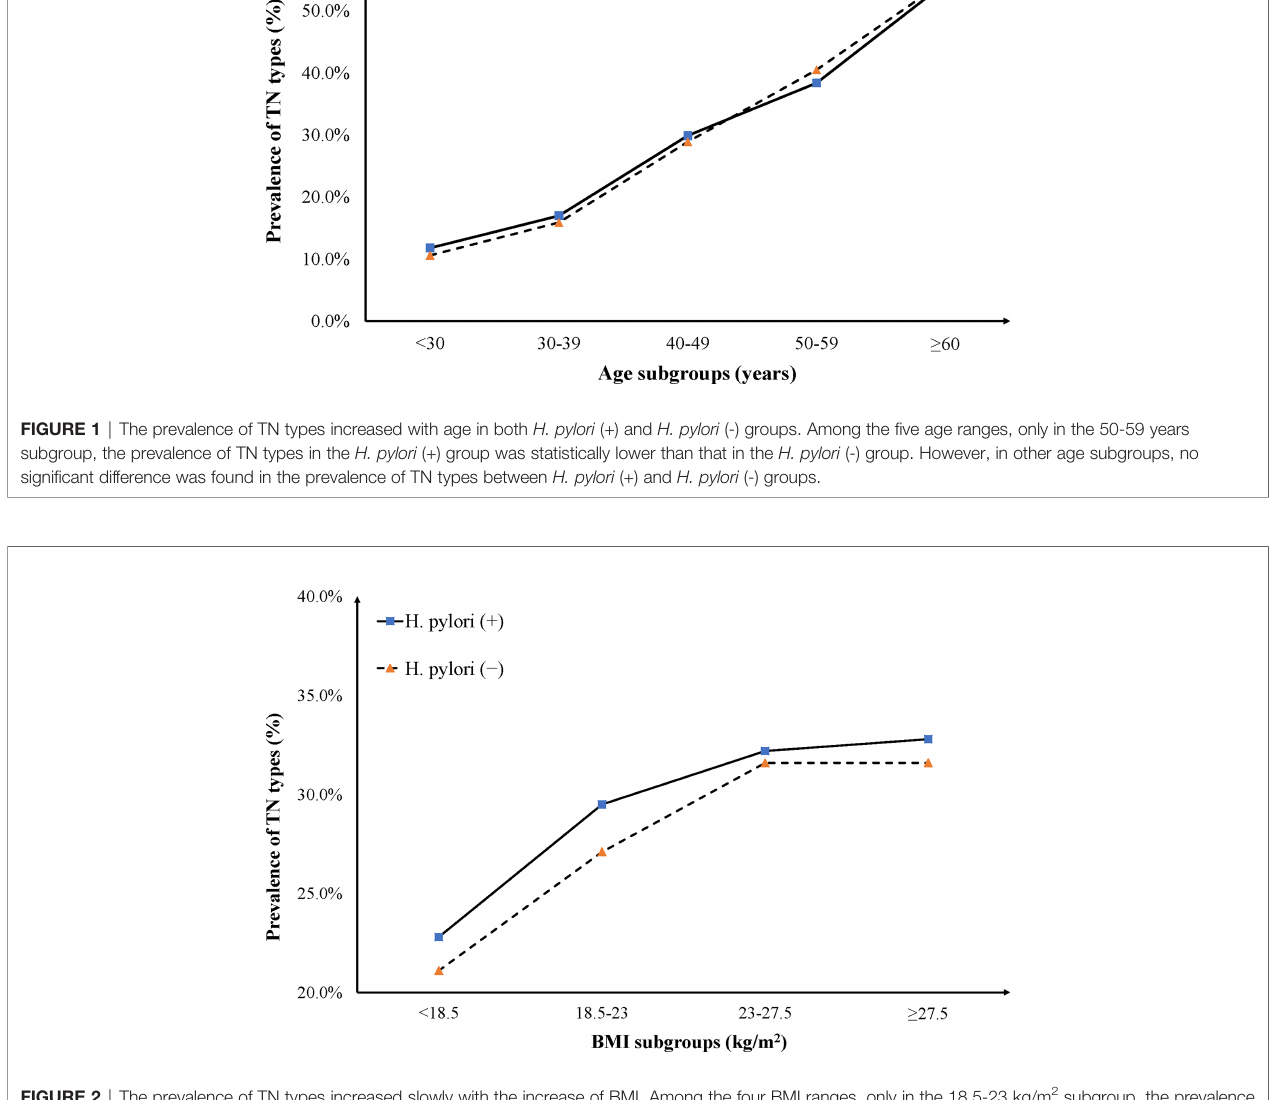
FIGURE 2 | The prevalence of TN types increased slowly with the increase of BMI. Among the four BMI ranges, only in the 18.5-23 kg/m 2 subgroup, the prevalence of TN types in the H. pylori (+) group was statistically higher than that in the H. pylori (-) group, and no signi fi cant difference was found in the prevalence of TN types between H. pylori (+) and H. pylori (-) groups in other BMI subgroups